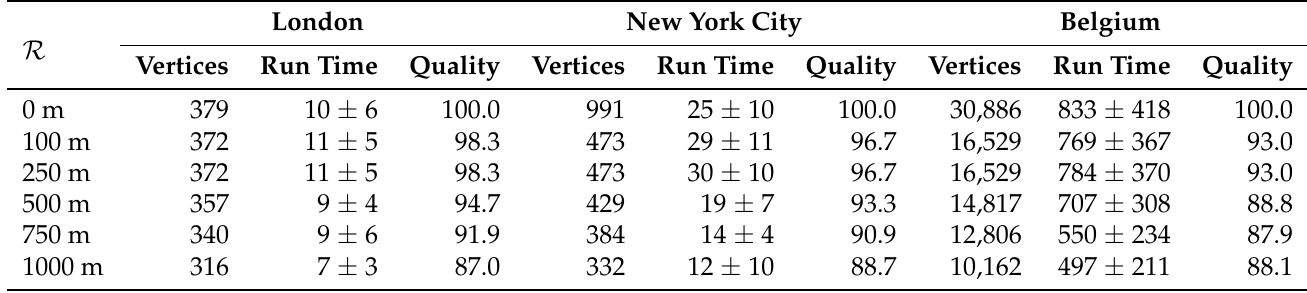
Table 2. Performance metrics for vertex merging with different parameter